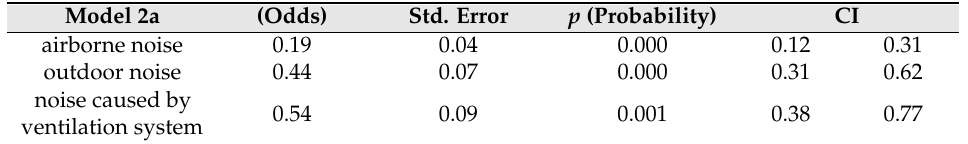
Table 12. Model 2a, ordinary logistic model describing relationship between satisfaction of indoor acoustic quality and perceived frequency of experienced problems; N = 412, pseudo R-squared = 0.12.